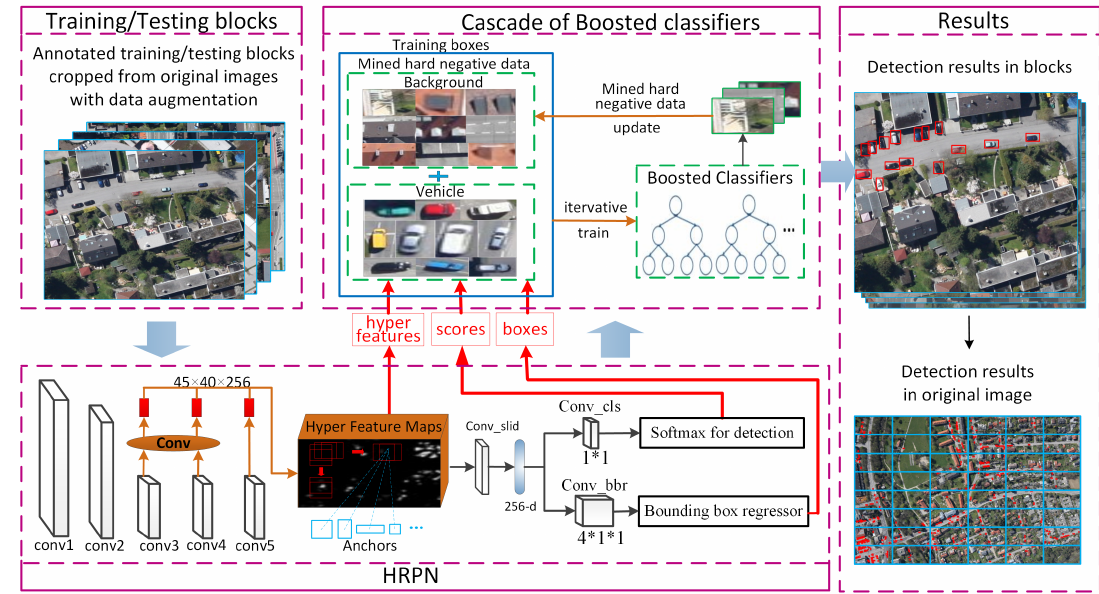
Figure 2. Proposed vehicle detection framework. Original large scale images are cropped into small scale blocks for training and